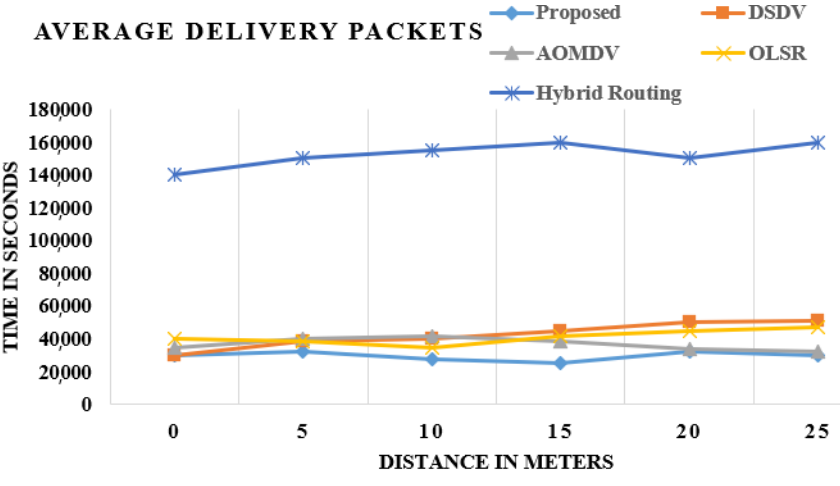
Figure 5. Comparison of packet delivery.